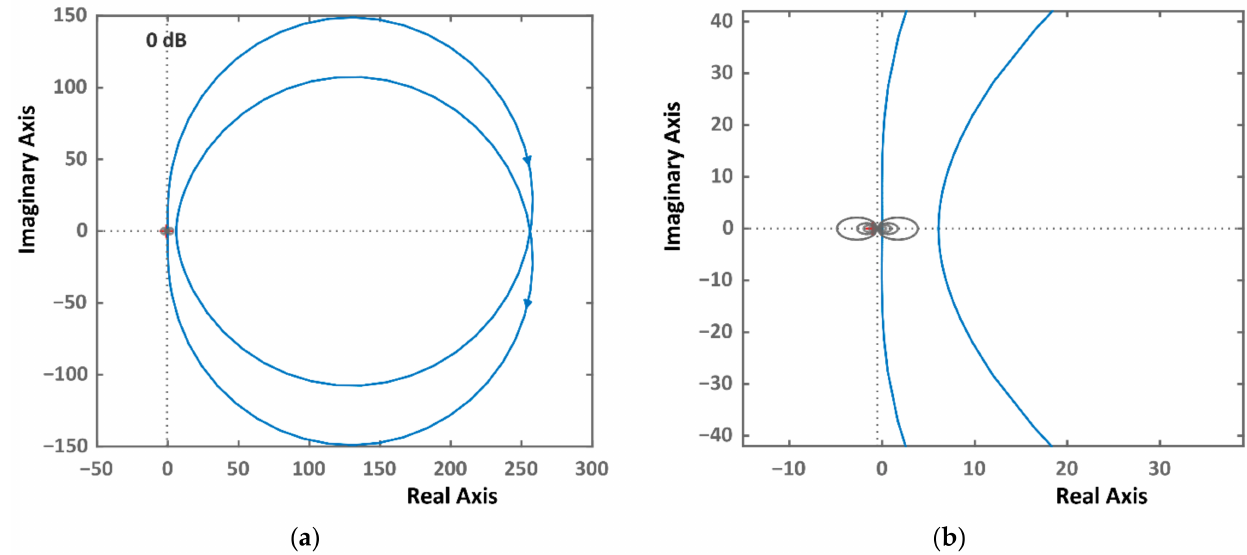
Figure 19. Impedance ratio. ( a ) Nyquist plot under balanced grid condition with the proposed feedback controller; ( b ) zoom in ( − 1,